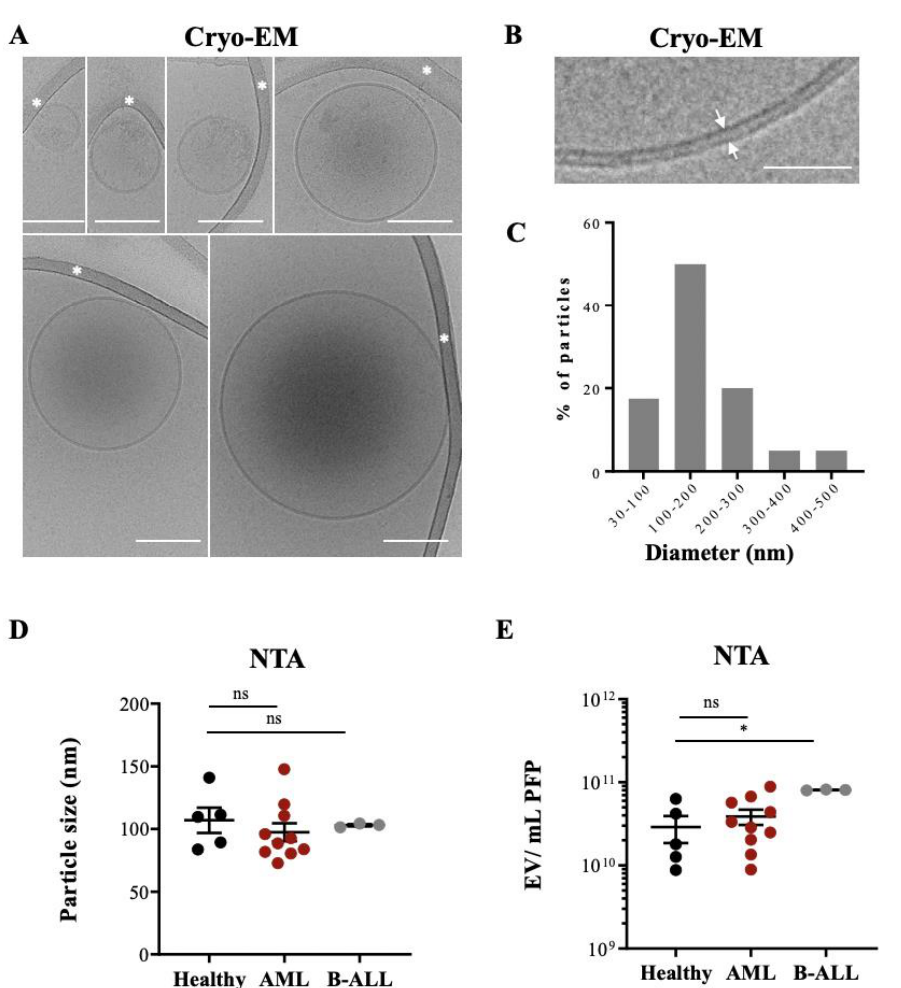
Figure 1. Cryo-EM of EVs isolated from leukemia-derived PFP samples: ( A ) Assembly of six micrographs showing single EVs of different sizes embedded in a thin film of frozen EV preparation. Some vesicles show an electron dense cargo in their lumen. Scale bar, 100 nm. White asterisks mark strands of the supporting carbon net. ( B ) The lipid bilayer at the vesicle membrane is resolved in two discrete lines 4 nm apart (arrows). Scale bar = 50 nm. ( C ) The histogram shows the size distribution of 50 EVs from one AML patient, determined by Cryo-EM. ( D ) PFP samples isolated from HBD (n = 5), AML (n = 10), and B-ALL (n = 3) patients were analyzed by NTA in light scatter mode and median particle size was determined. ( E ) Particle concentration (EVs/mL) of PFP samples from HBD and AL patients were measured by NTA. One-way ANOVA with post hoc Bonferroni was performed for multiple group comparison. * p < 0.05; ns, non-significant.